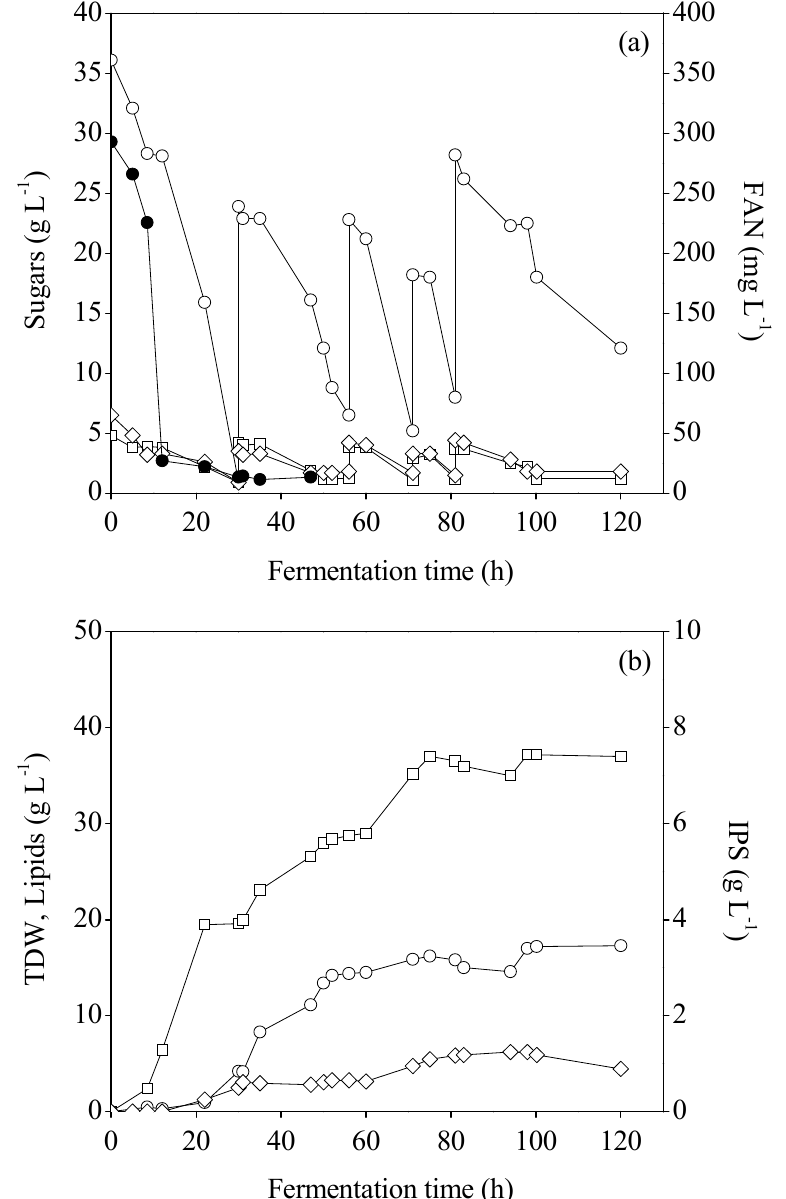
Figure 3. ( a ) Concentration of glucose ( Figure 3 ( a ) Concentration of glucose ( ○ ), fructose ( □ ), galactose ( ◊ ), free amino nitrogen (FAN) ( ● ) and ( b ) production of total dry weight (TDW) ( □ ), microbial lipids ( ○ ), intracellular polysaccharides (IPS) ( ◊ ) during fed-batch bioreactor fermentations of R. toruloides on mixed confectionery waste streams (MCWS) hydrolysates.